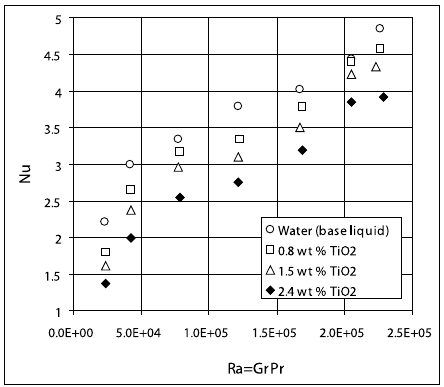
Fig. 5 Comparison of measured thermal conductivity enhancement with the model based on nanoparticle structuring: based TiO 2 nanofluids.